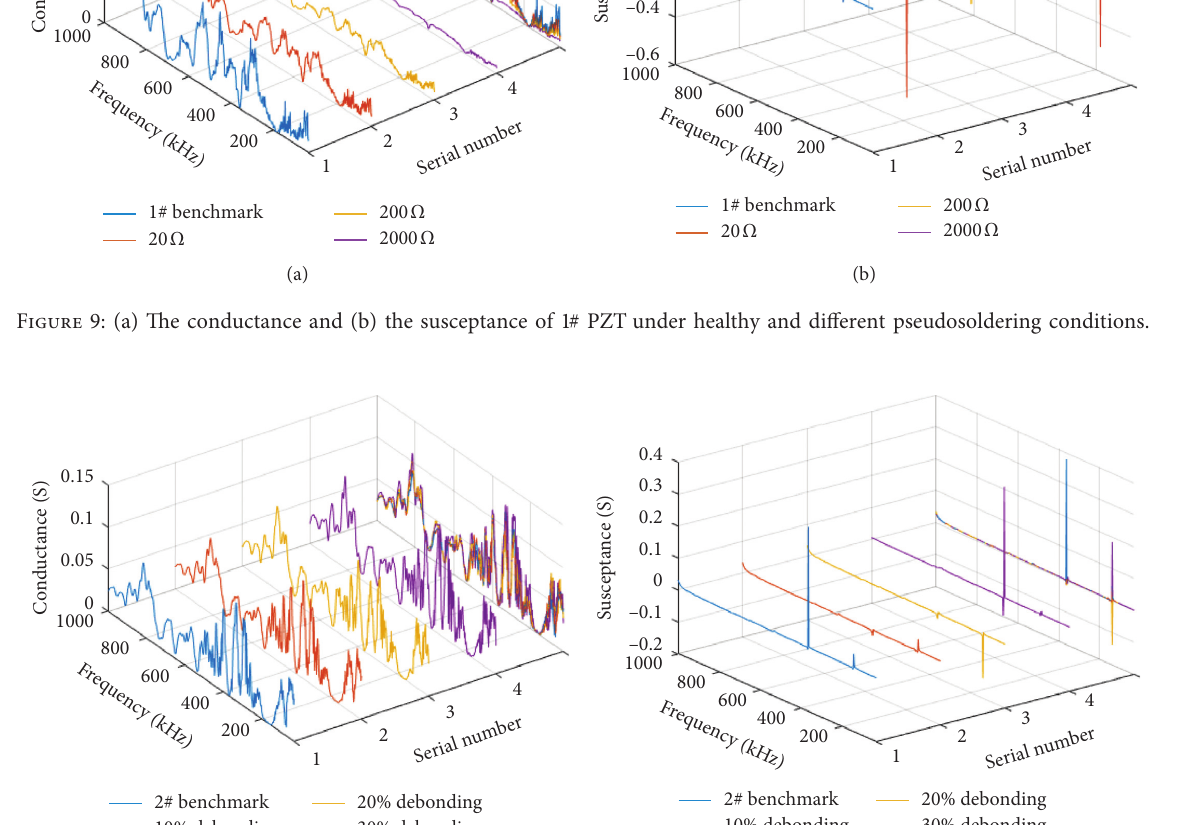
Figure 10: (a) The conductance and (b) the susceptance of 2# PZT under healthy and different debonding